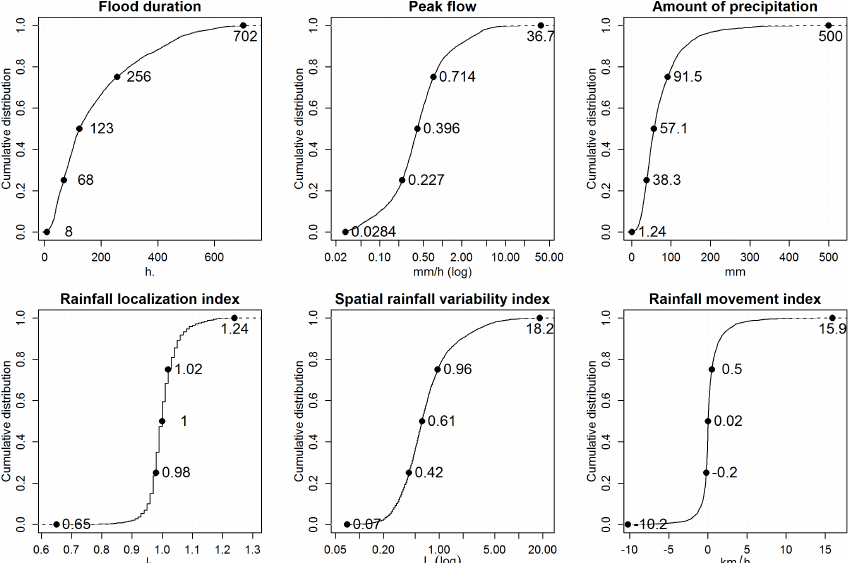
Fig. 6. Cumulative distribution of flood durations, peak values, event-based amounts of precipitation, localization, spatial variability and rainfall movement indexes of precipitation fields for the 3620 observed events in the 181 selected catchments (values for the minimum, 25th, 50th, and 75th percentiles, and the maximum are indicated on the cumulative distribution axes).